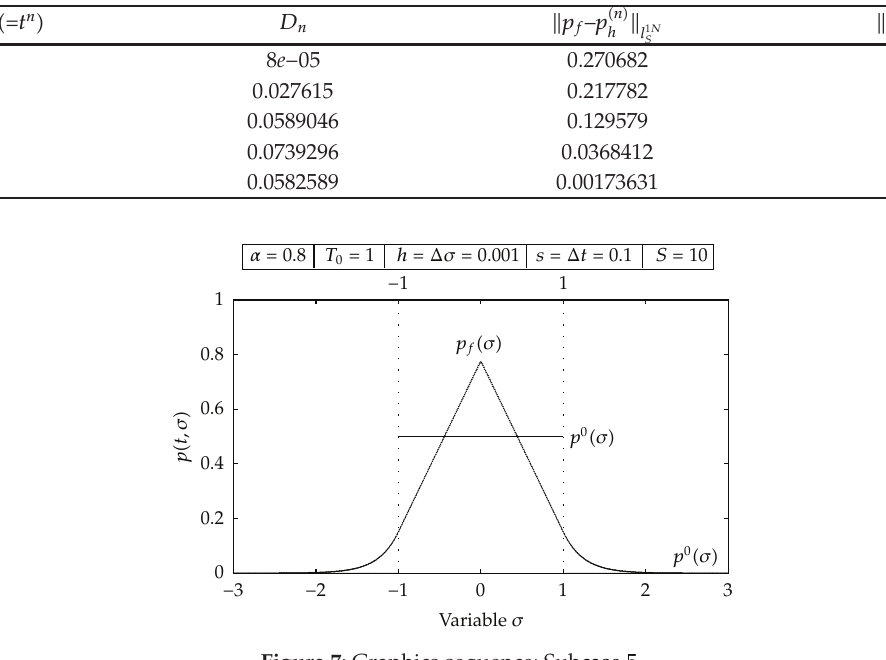
Table 5: Numerical results: Subcase 5.